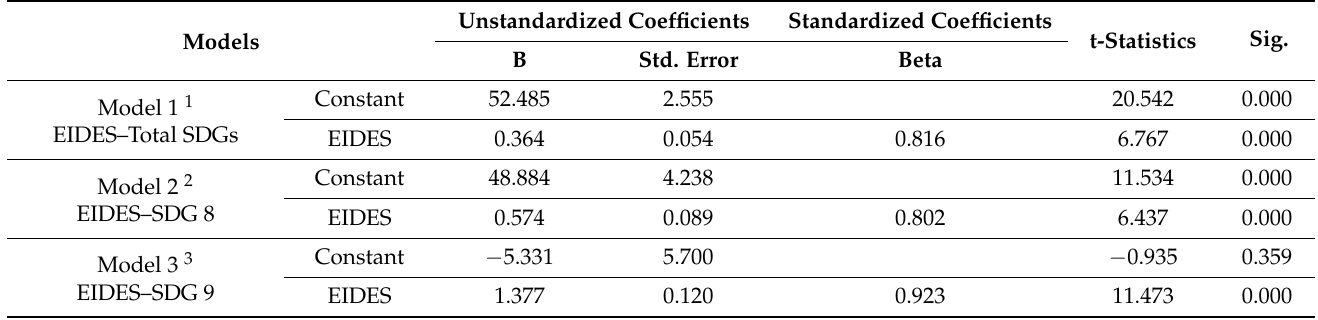
Table 3. Regression results: the impact of digital entrepreneurship (EIDES) on the achievement of SDGs (Total SDGs, SDG 8 and SDG